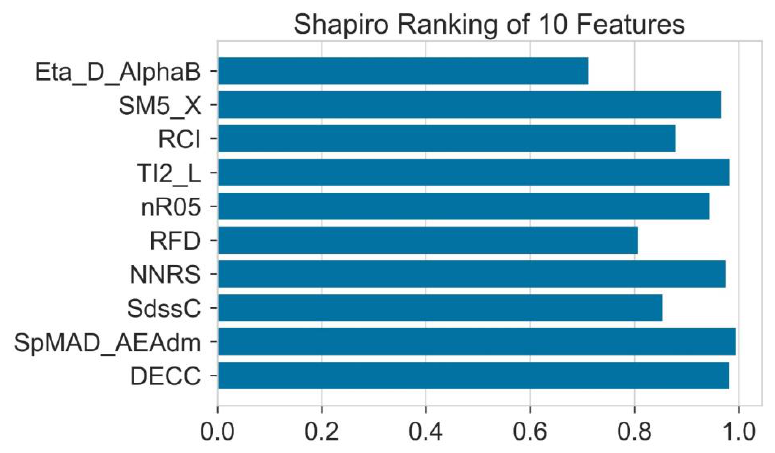
Figure 3. The normality of all the features analyzed by Shapiro test.